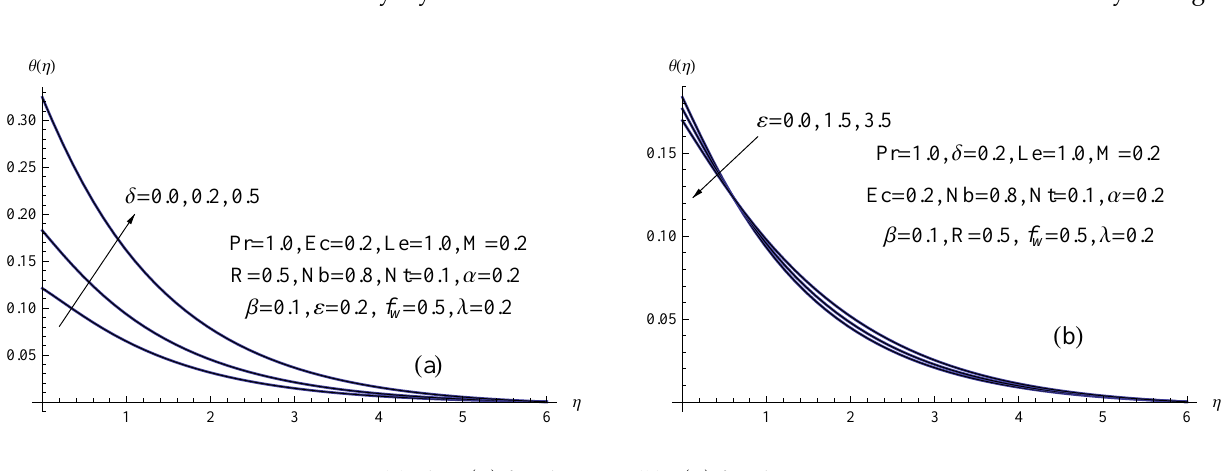
Figure 8. ( a ) The θ ( η ) for chosen δ , ( b ) θ ( η ) for chosen ε . Additionally, Figure 9 shows the temperature field θ ( η ) outcomes for the Brownian motion parameter Nb and the thermophoresis parameter Nt . The particles’ erratic motion generates extra kinetic energy, which boosts the thermal energy that is already there. As a result, a rise in Nb causes the fluid temperature in the boundary layer’s thermal domain to increase faster. The Maxwell nanofluid temperature and the sheet temperature θ ( 0 ) both accelerated similarly as a result of the increase in the thermophoresis parameter Nt .